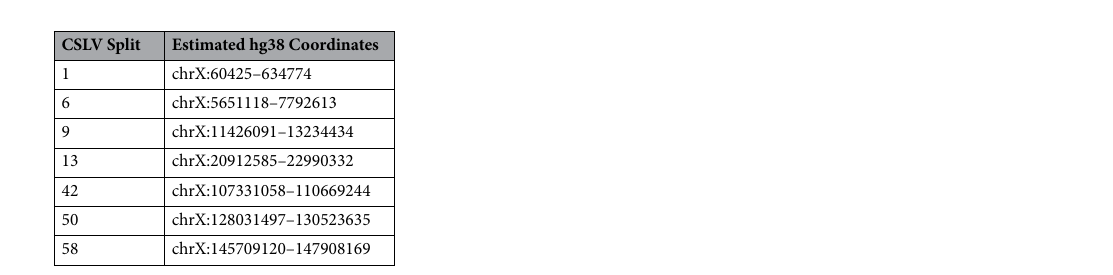
Table 3. This table shows the estimated hg38 coordinates for the corresponding CSLV splits with high variable importance as shown in Fig. 7.